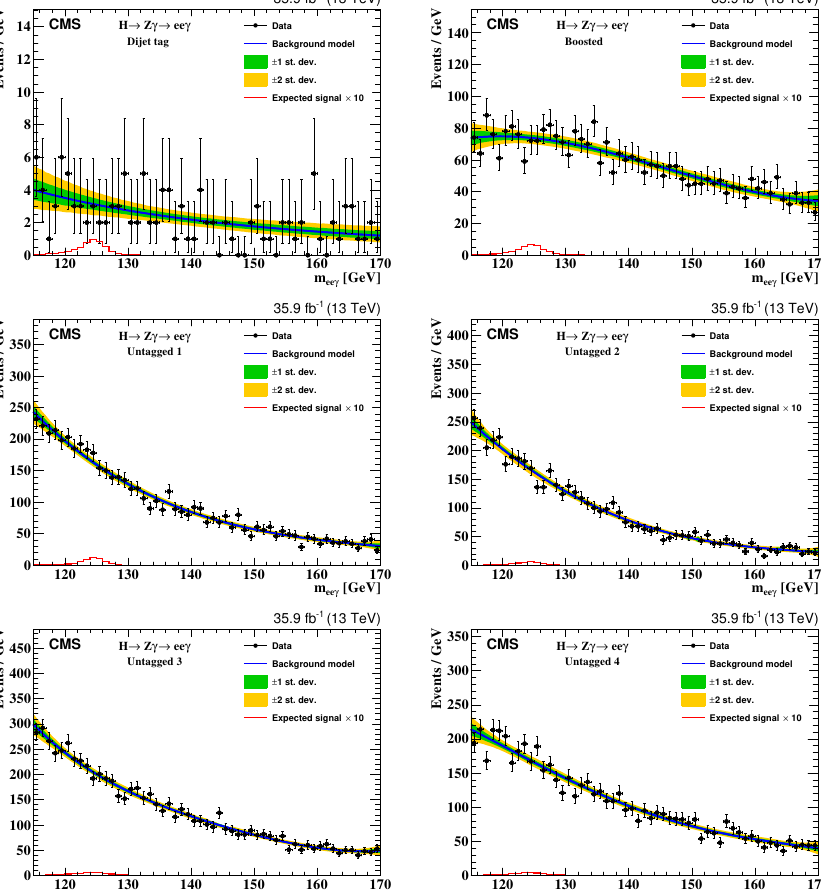
Figure 3 . Background model (cid:12)t to the m ee (cid:13) distribution for dijet tag (upper left), boosted (upper right), untagged 1 (middle left), untagged 2 (middle right), untagged 3 (bottom left), and untagged 4 (bottom right) for the H Z (cid:13) ee (cid:13) selection. The green and yellow bands represent the 68 ! ! and 95% CL uncertainties in the (cid:12)t to the